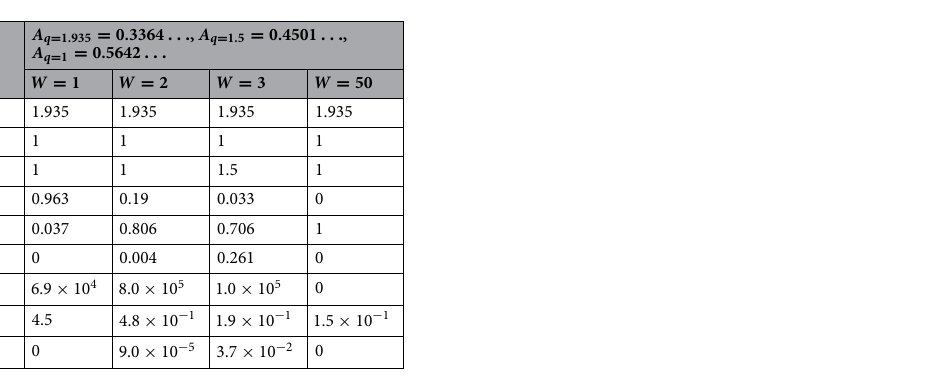
Table 4. The obtained parameter values of the probability distributions for K = 0.6 systems given in Fig.